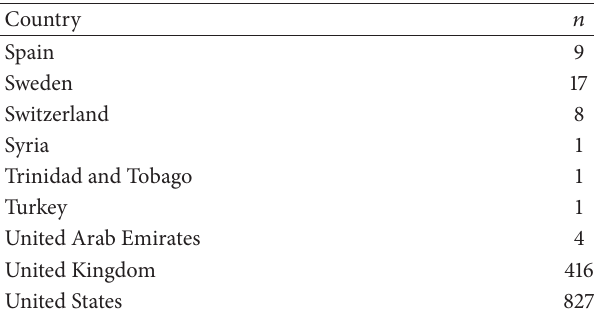
Table 10: Country of residence. Table 10: